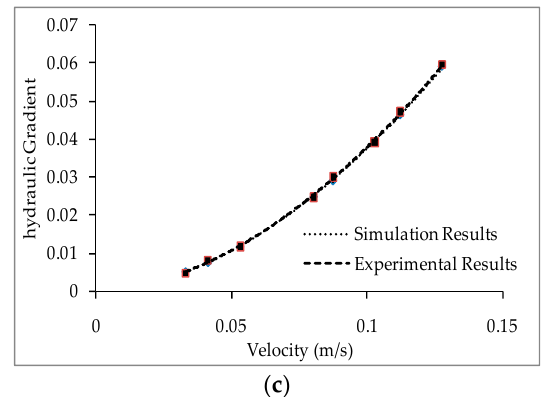
Figure 9. Comparison of simulation and experimental results for 29.8 mm media packed with ( a ) 40.59%; ( b ) 43.34%; and ( c ) 45.69% porosities.